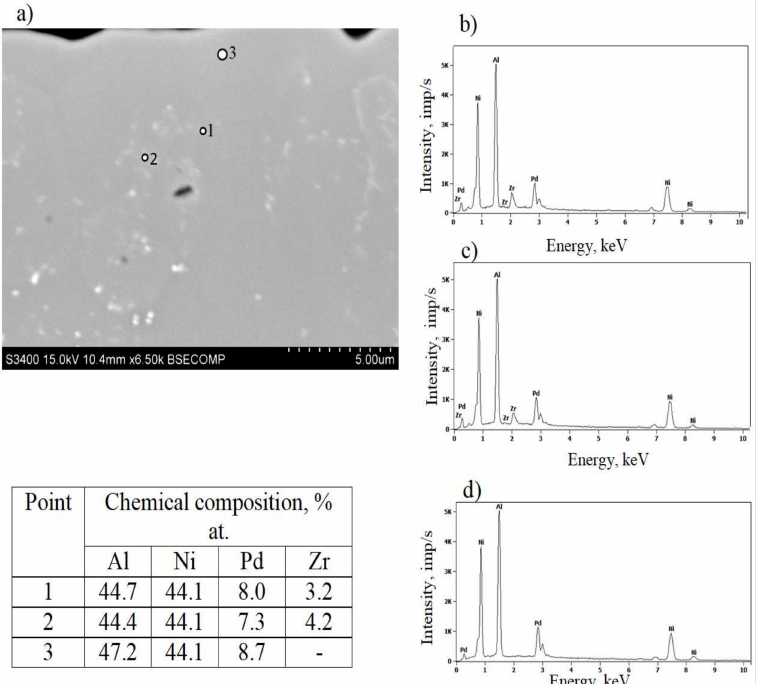
Figure 4. SEM microstructure on the cross-section of the additive zone of the palladium and zirconium